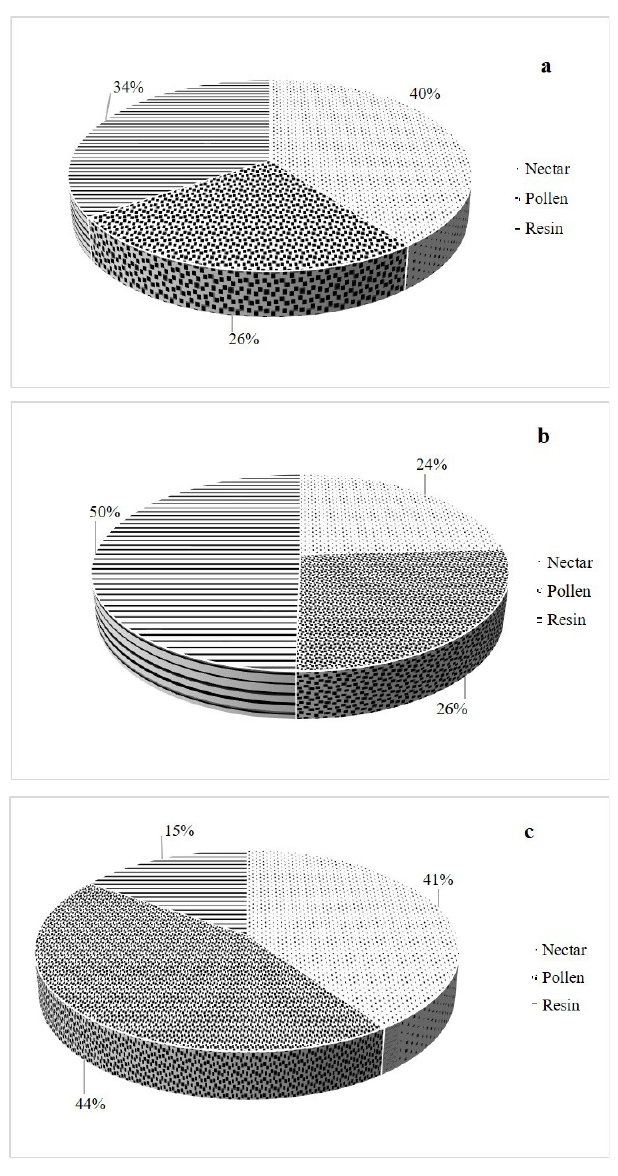
Fig 2 . Forage resource partitioning during 15 (a), 30 (b) and 45 (c) days after acceptance of traps by stingless bees